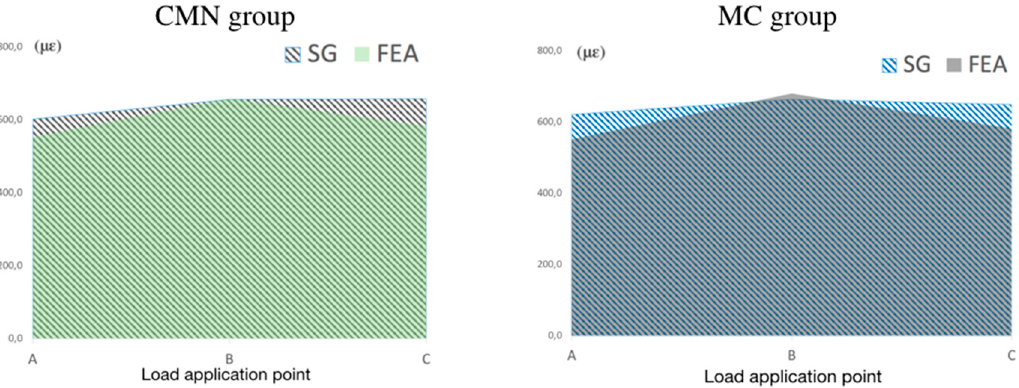
Figure 6. Microstrains mean the CMN and MC groups for both methodologies according to the different loading points.